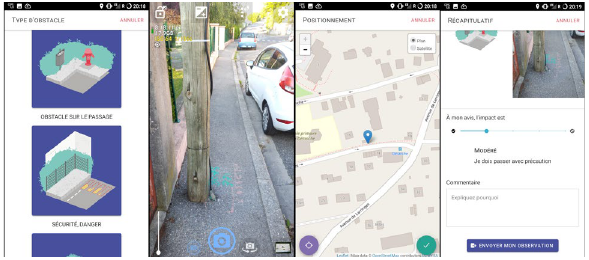
Figure 2. Main screens of the explorer mobile app